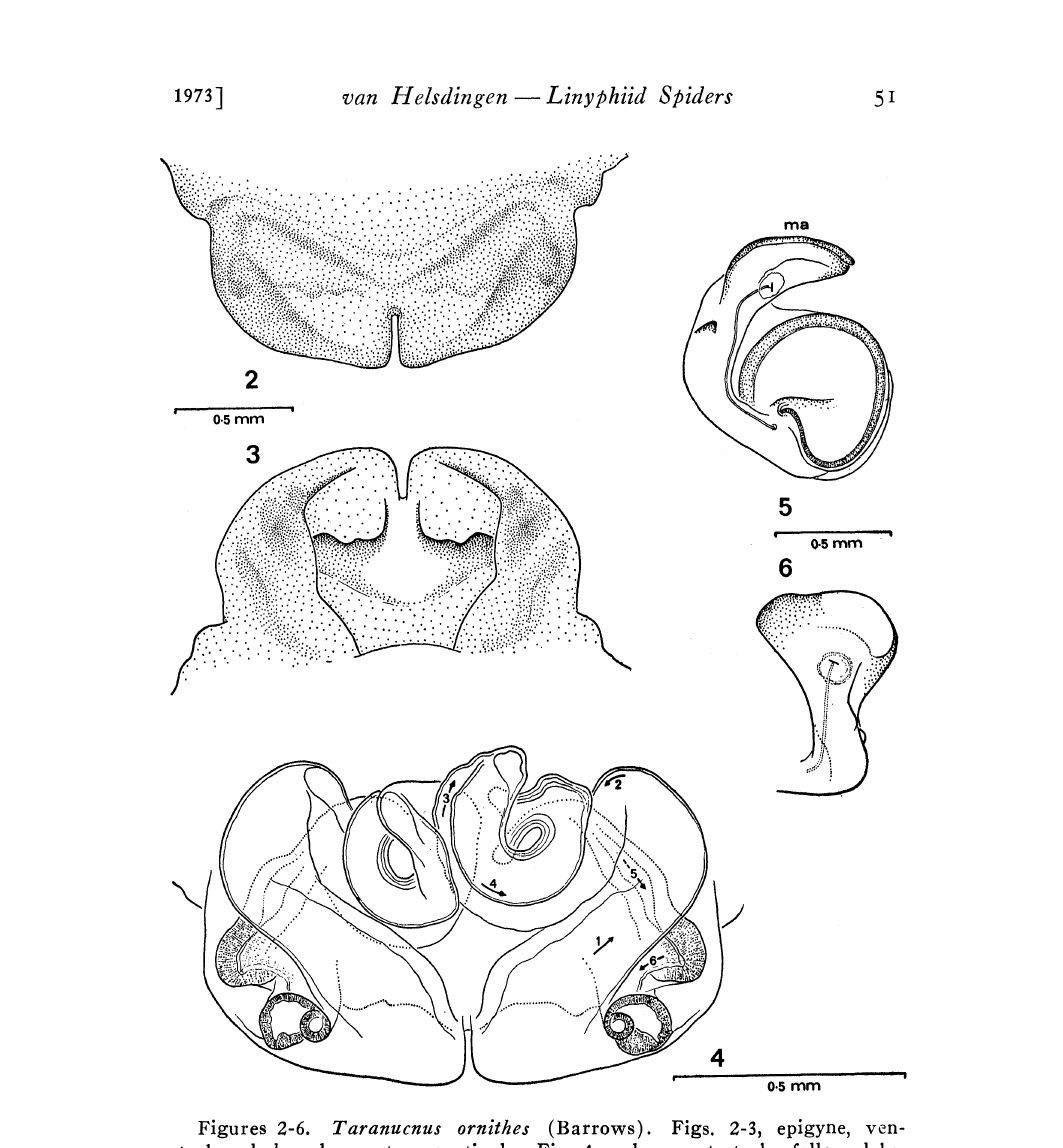
Figures 2-6. Taranucnus ornithes (Barrows). Figs. 2-3, epigyne, ven- tral and dorsal aspect, respectively. Fig. 4, vulva, route to be followed by embolus indicated by consecutively numbered arrows. Fig. 5, tegulum and median apophysis (ma) of male palp. Fig. 6, median apophysis, dorsal